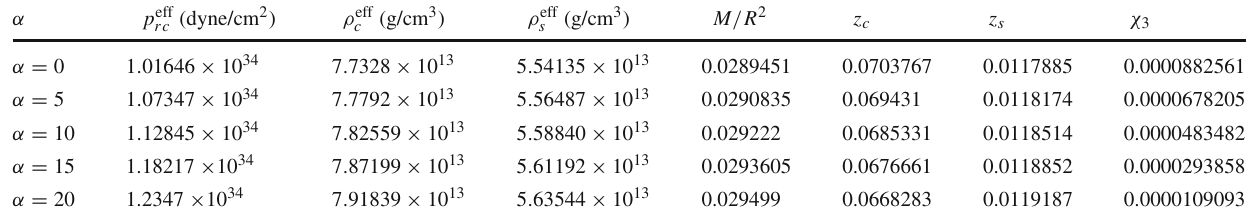
Table 1 Numerical values of physical parameters of the MGD solution for C = 0 . 0021km − 2 , D = 0 . 0015 km − 2 , R = 11 km , χ 1 = 0 . 2 and χ = 1 / 3 with different coupling parameters α for fix decoupling constant β = − 0 . 6 2